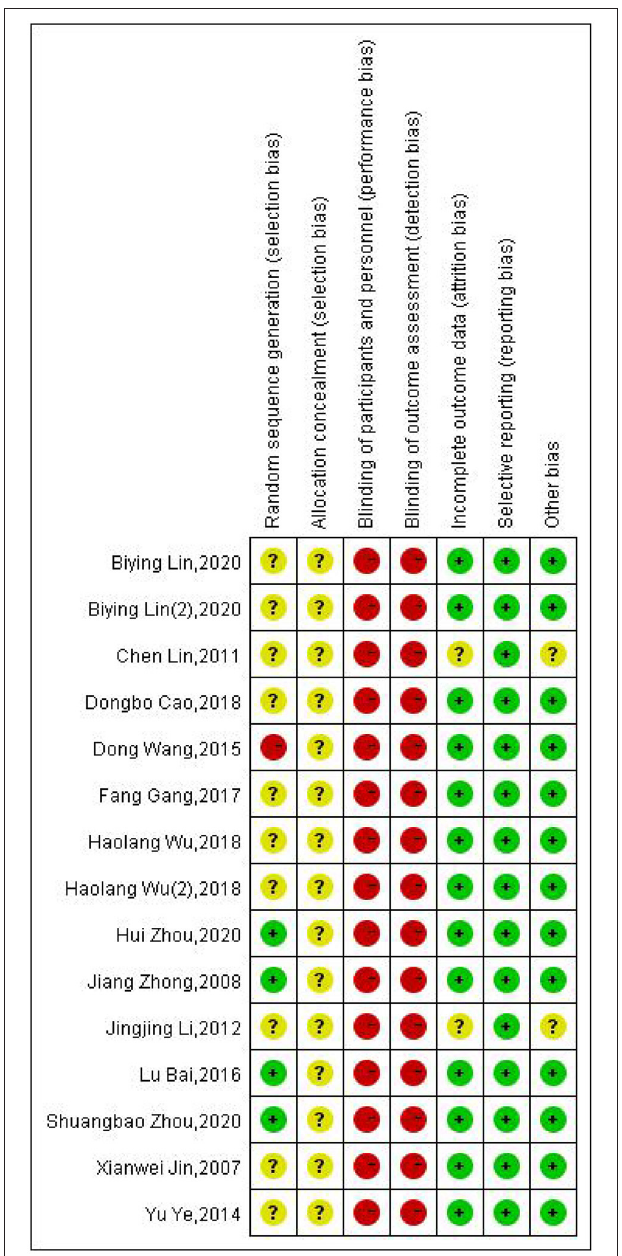
FIGURE 2 | An evaluation of risk bias in the included randomized controlled trials (RCTs).